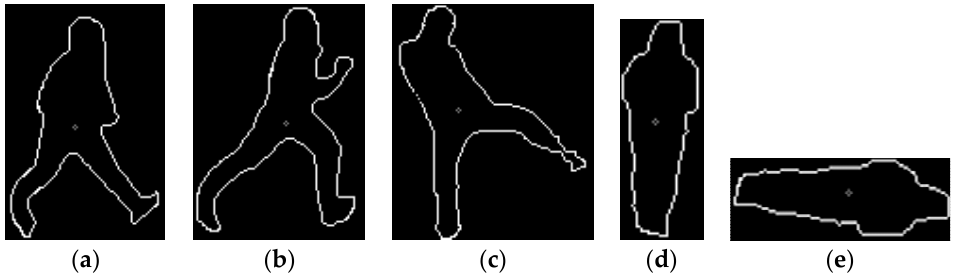
Figure 14. Examples of cases in which the Fourier descriptor-based method produced an erroneous recognition result. ( a ) Walking; ( b ) running; ( c ) kicking; ( d ) standing; ( e ) lying down. GEI-based methods have similar patterns for walking, running, and kicking behaior. Therefore, running was recognized as walking (see Figure 15c,d). In addition, a kicking image produced by GEI PPV and consequent F_score of kicking are low as shown in Table 7.